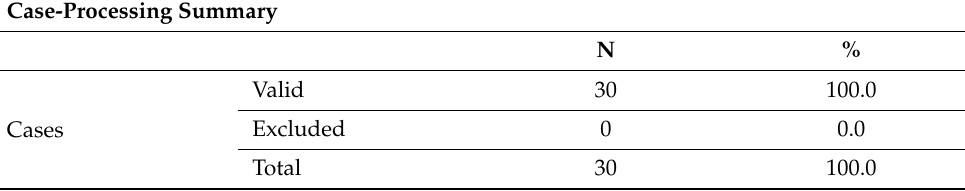
Table 4. Results of the reliability test.